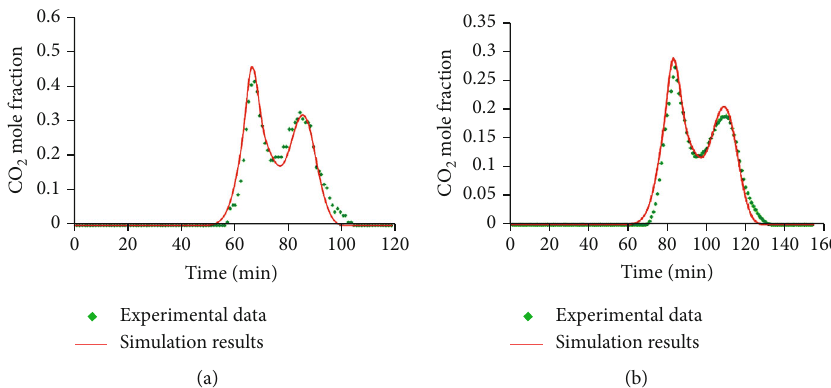
Figure 8: (a) CO production history match for the kinetic cell (RTO) experiments with heating rates of 5.22 ° C/min; (b) CO 2 history match for the kinetic cell (RTO) experiments with heating rates of 3.22 ° C/min.